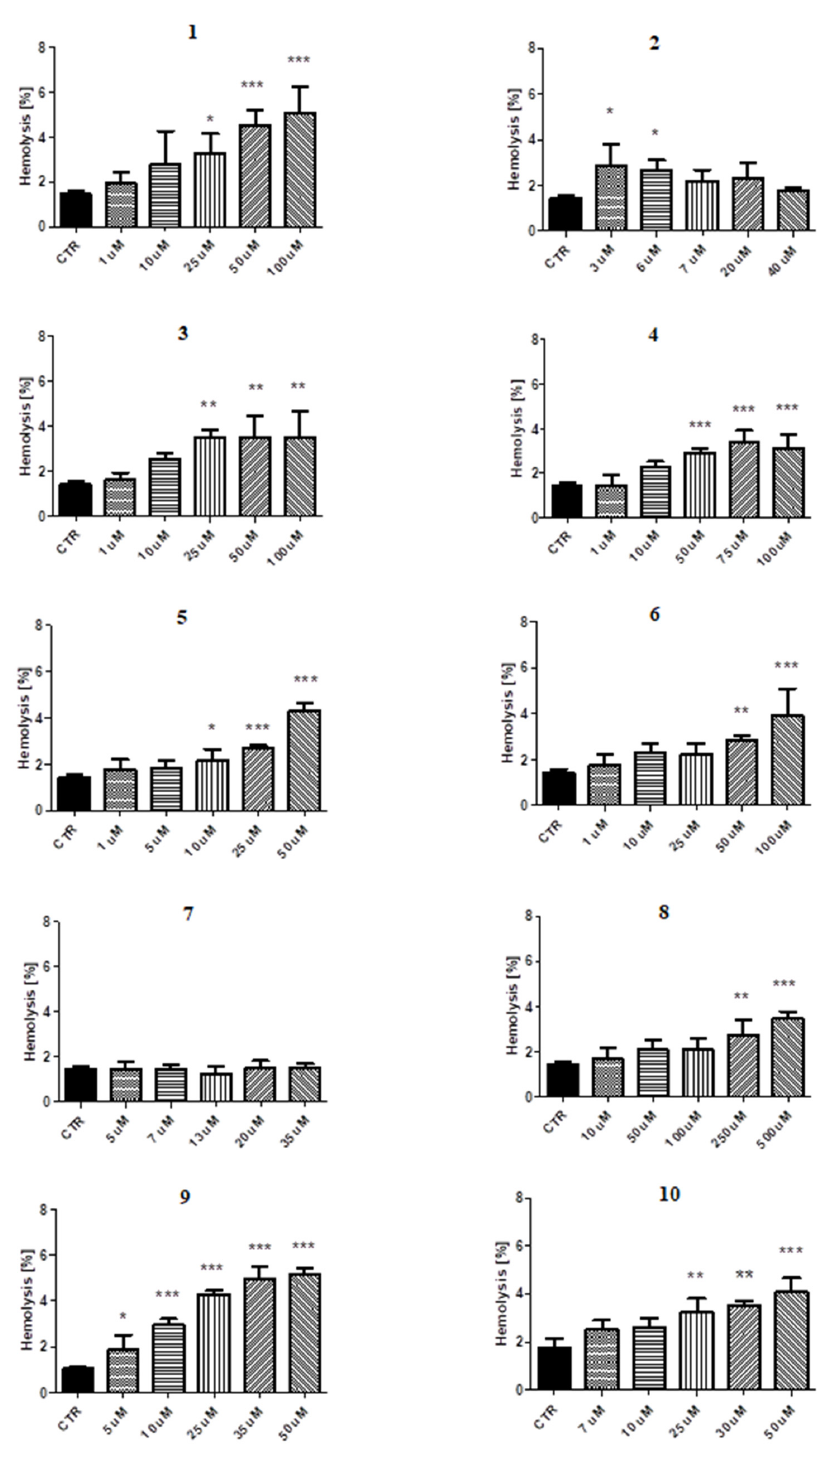
Figure 5. The effects of reference compounds, flavanone and chromanone ( A ) and synthesized compounds ( B ) on the integrity of the erythrocyte membrane. The results are presented as the percentage of hemolysis obtained from the interaction of studied compounds with 2% RBCs (red blood cell) suspension, compared to the positive control Triton X-100 constituting 100% hemolysis. The results are presented as mean ± SD; n = 4, * p < 0.05 vs. control; ** p < 0.01; *** p <